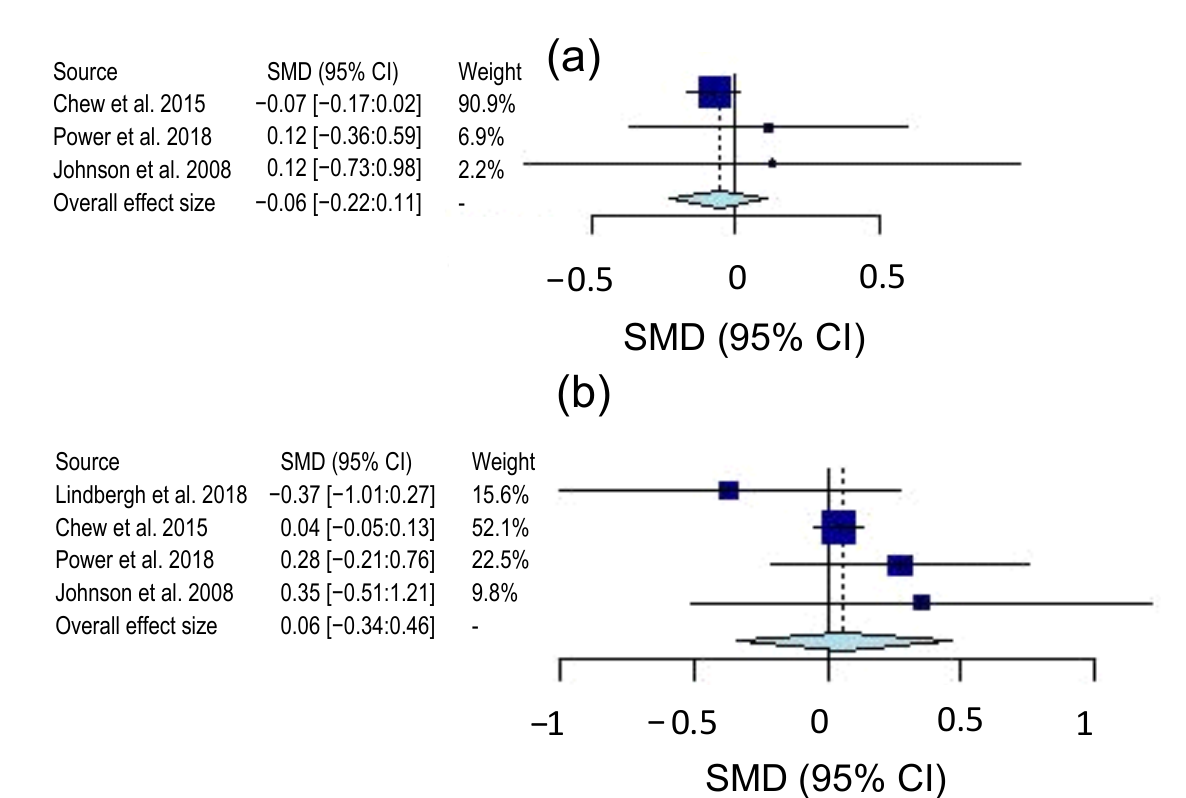
Figure 3. Forest plots of cognitive domains: ( a ) complex attention, ( b ) executive function and ( c ) memory. All plots express effect size as Hedge’s g SMD with 95% confidence interval and study weight.